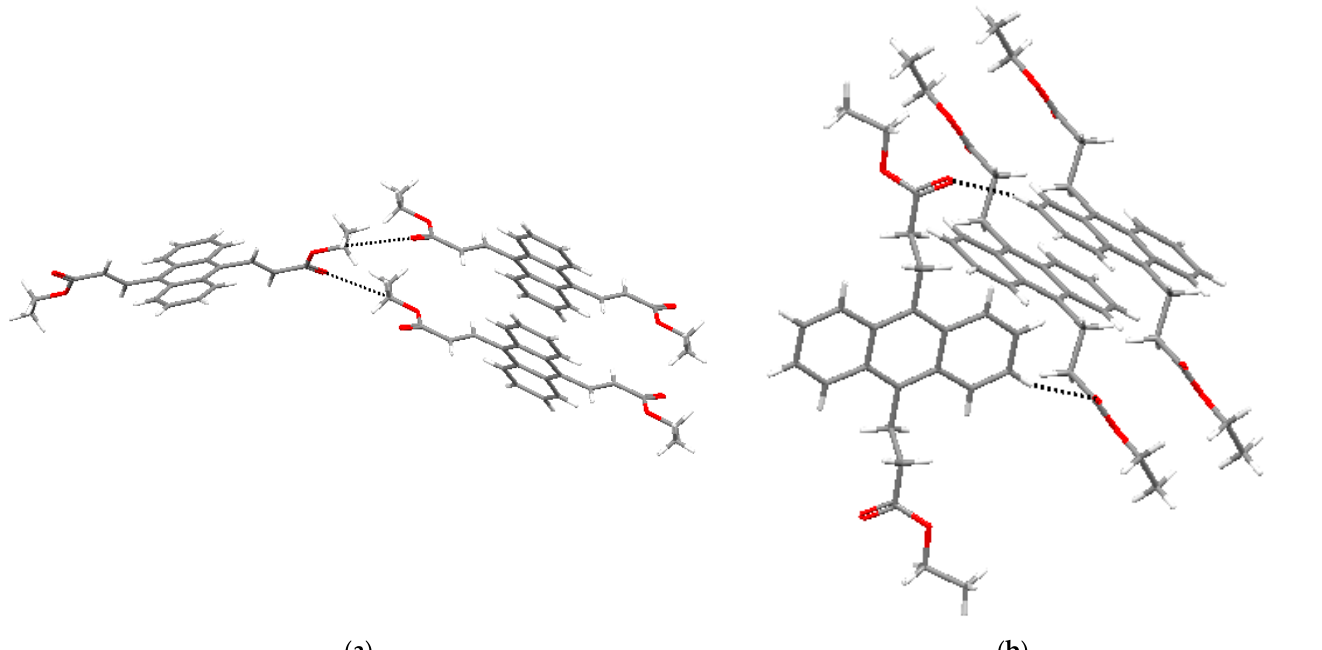
Figure 13. Arrangements observed in DADB ( a ) and DEADP ( b ) crystals. Through NBO calculations, it was possible to determine the stabilizing interactions between the donor bonding orbitals (Lewis type) and acceptor antibonding (non-Lewis type) in the molecules of the crystals of DADB (Table 3) and DEADP (Table 4). The interactions present between the bonding orbitals (donors) and the antibonding orbitals (acceptors) have low hyperconjugation energies. The frontal contact between two DADB molecules showed that there are preferential hyperconjugations between the bonding σ orbitals the C 11 –H and C 11i –H bonds—where the donor orbitals have an occupancy slightly higher than 1.98e, while the acceptor orbitals have an occupancy of 0.02e. The isolated pairs of electrons from the O atom of the carbonyl of a molecular unit also participate in this intermolecular interaction through hyperconjugation with antibonding σ * orbitals of the O 1 –C 11 and C 12 –H bonds of the second molecular unit. In the axial contact between the DADB molecules, it is possible to observe a large amount of hyperconjugation between the binding π orbitals of one molecular unit with the antibonding π * orbitals of the second molecular unit. These hyperconjugations have low energies, but in general, higher than 0.1 kcal · mol − 1 , especially in the interactions that occur in the region of the aromatic ring of anthracene. In DEADP crystals, frontal contact between molecular units occurs weakly through σ and π hyperconjugations, and through isolated pairs of electrons on the O atom of the carbonyls of one molecular unit with the antibonding orbitals of the other unit. The axial contact results in numerous interactions that are weakly stabilized thanks to the large contact surface in the planar region of the aromatic ring of the anthracene core. Hyperconjugations of the bonding π orbitals with the antibonding π * orbitals have a greater stabilizing energy, as well as occur in the layered structure of DEADP crystals.